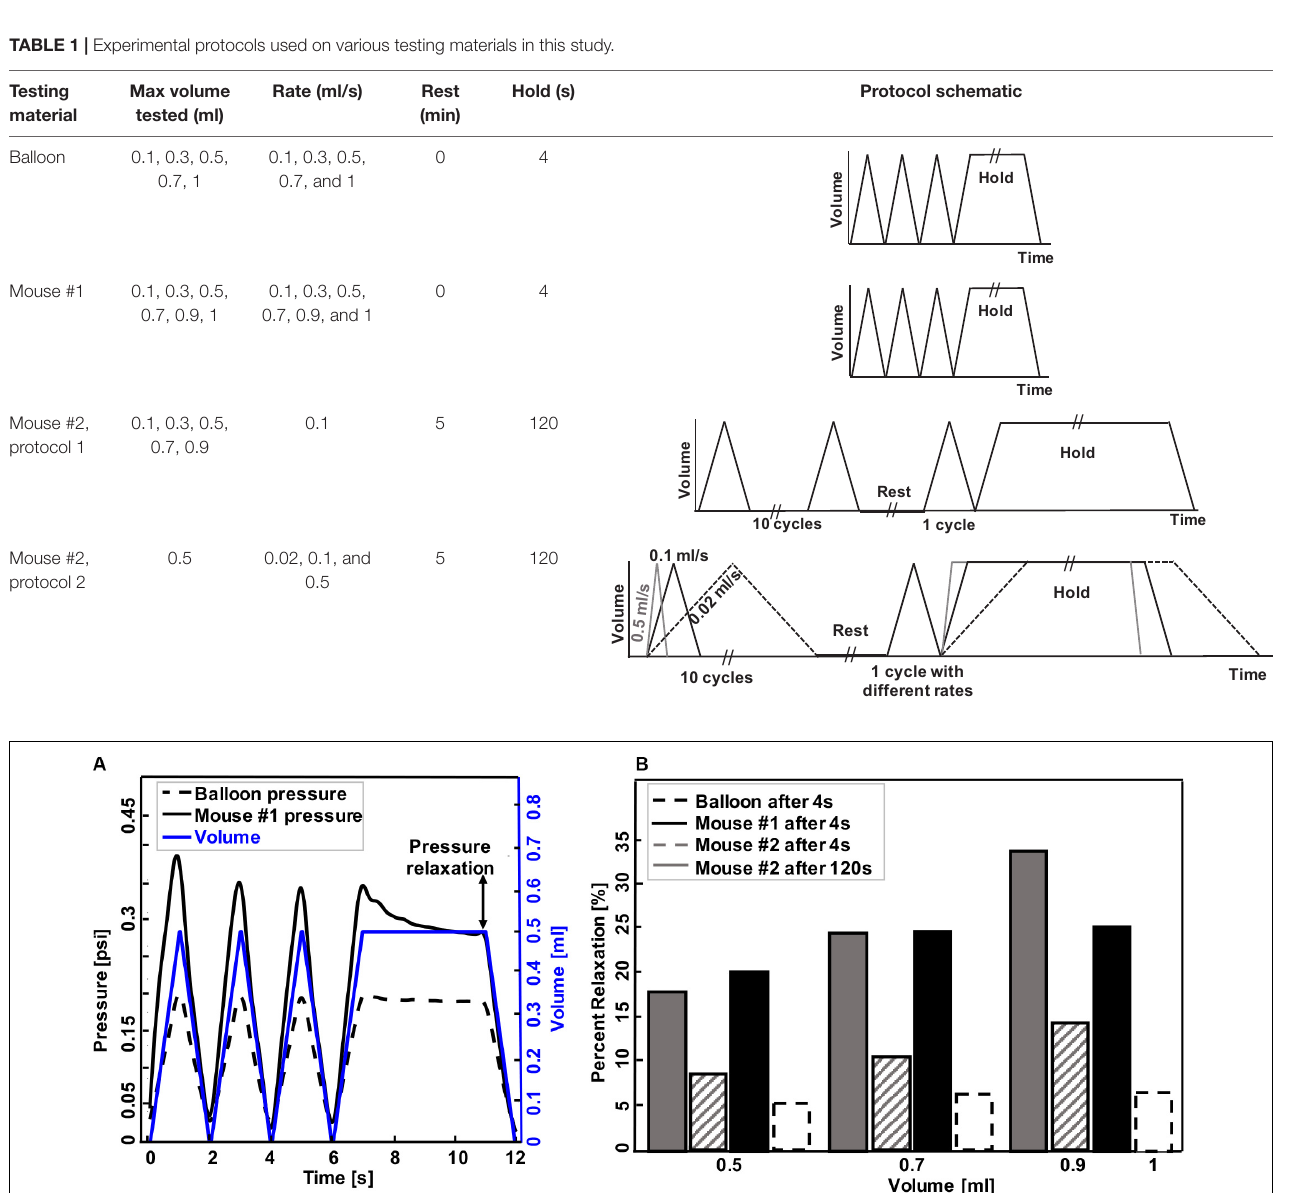
FIGURE 3 | A representative graph of volume-time protocol for mouse #1 and balloon and recorded pressure-time response (A) . Comparable percent relaxation for mice lungs and balloon at different maximum volumes and holding durations (B) . Rate of inflation-deflation for balloon and mouse #1 was 0.5, 0.7, and 1 ml/s for inflation volumes of 0.5, 0.7, and 1 ml, while the rate of inflation for mouse #2 was a constant value of 0.1 ml/s for all inflation volumes. Balloon and mouse #1 were held for 4 s, while the holding time for mouse #2 was 120 s. Minimum pressure values were determined after 4 and 120 s. As expected, the mouse lung